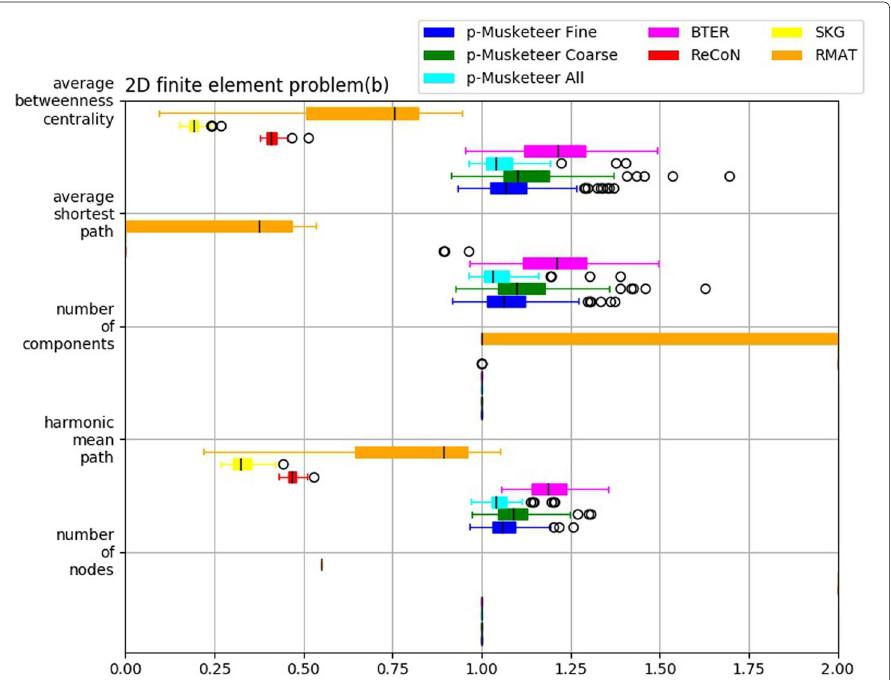
Fig. 15 Computational results on performance of planar Musketeer 2D finite element graph with 1866 nodes and 3538 edges for number of nodes, harmonic mean path, number of components, average shortest path and average betweenness